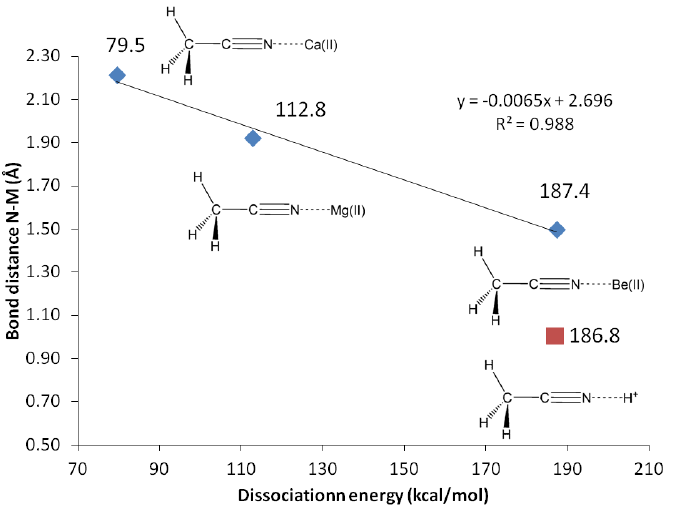
Figure 5. N3-Cation bond distance versus acetonitrile binding energy (G4,